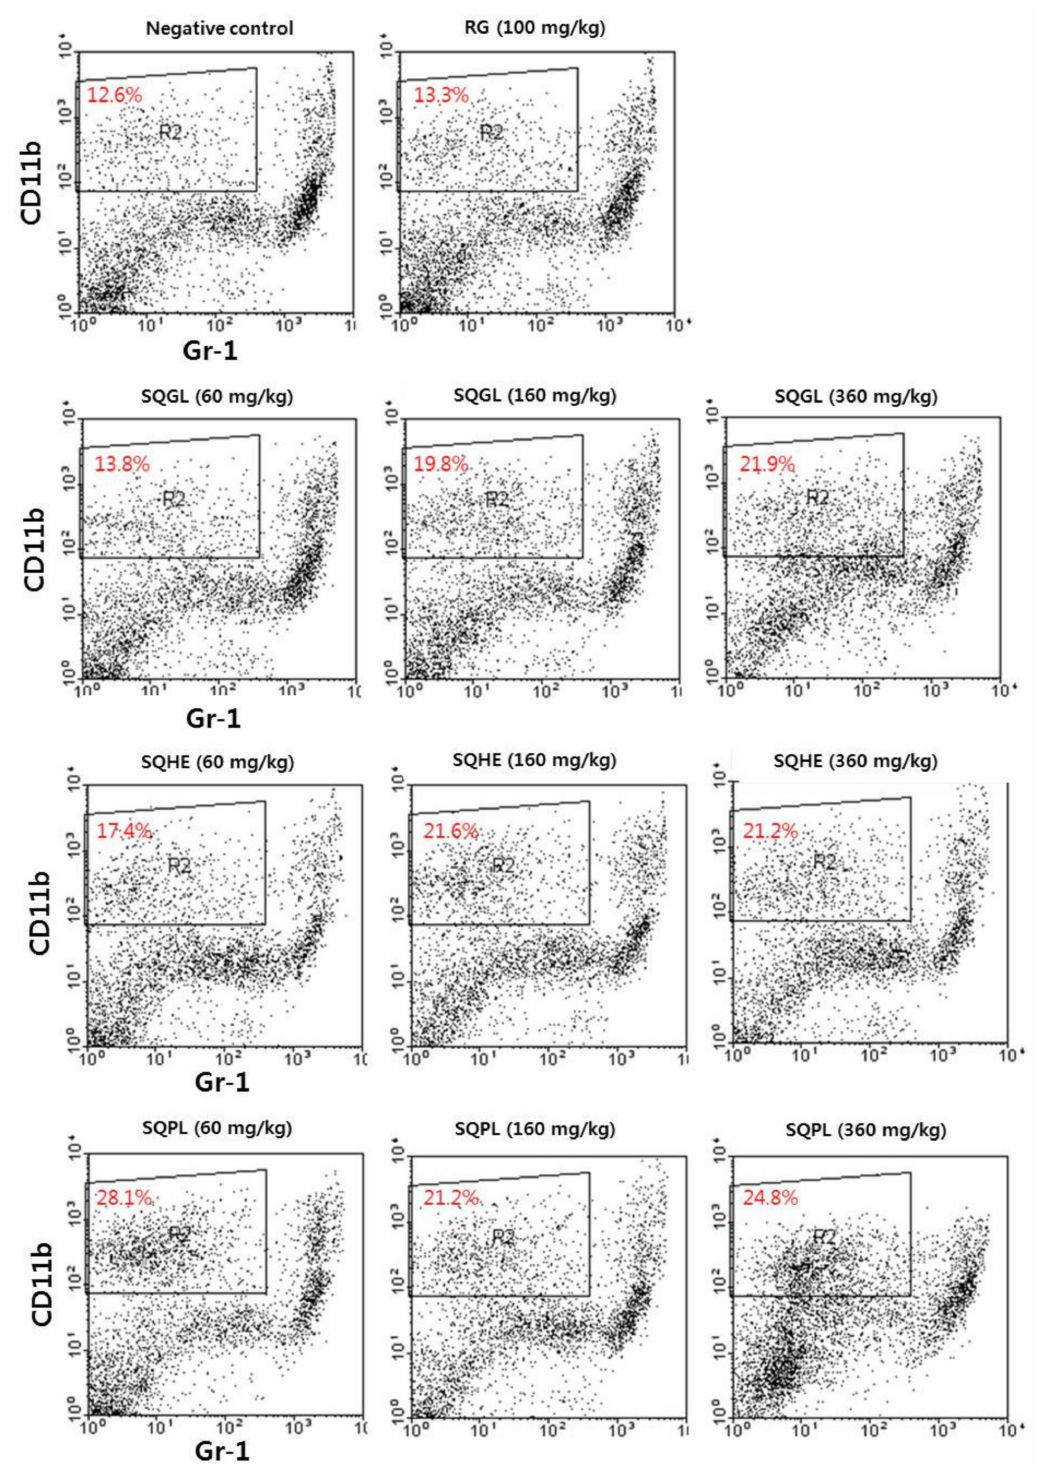
Figure 2. Changes of peritoneal macrophage population in the mice administered S. quelpaertensis leaves fermenta- tion products for two weeks. RG, red ginseng; SQGL, S. quelpaertensis leaves fermentation product by G. lucidum ; SQHE, S. quelpaertensis leaves fermentation product by H. erinaceum ; SQPL, S. quelpaertensis leaves fermentation prod- uct by P. linteus